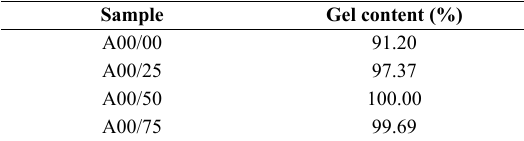
The decrease of gel content for a higher radiation dose is